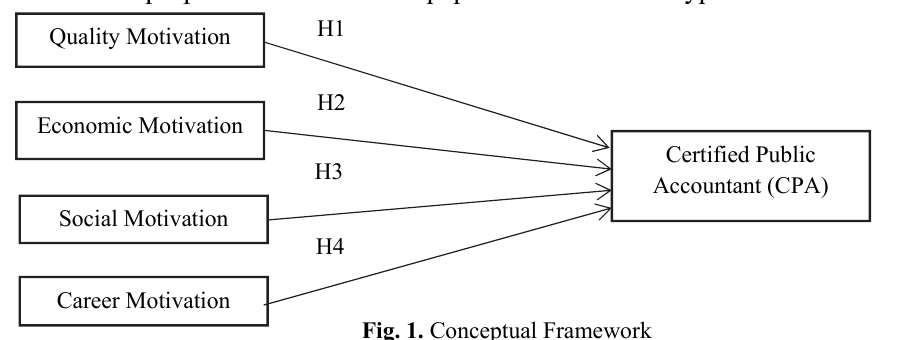
Fig. 1. Conceptual